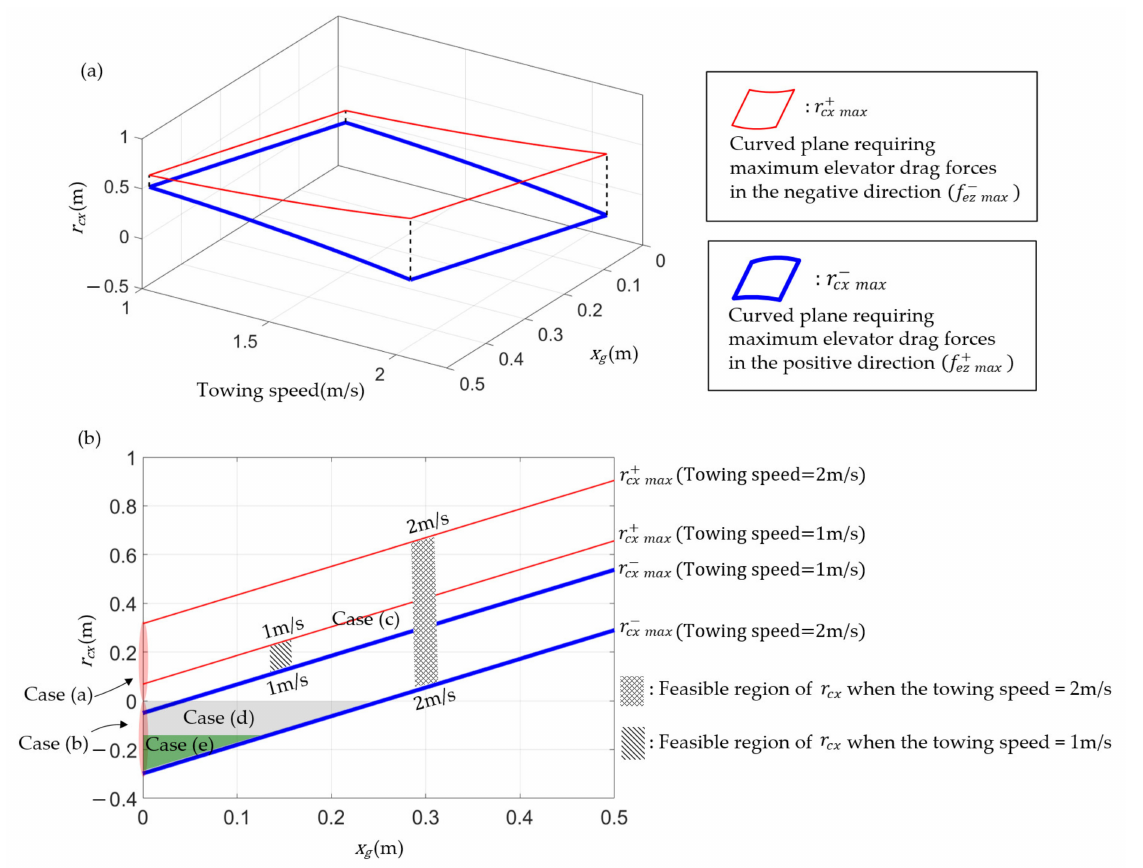
Figure 7. ( a ) Feasible region of r cx when x g and towing speed change and ( b ) when expressed along the r cx − x g